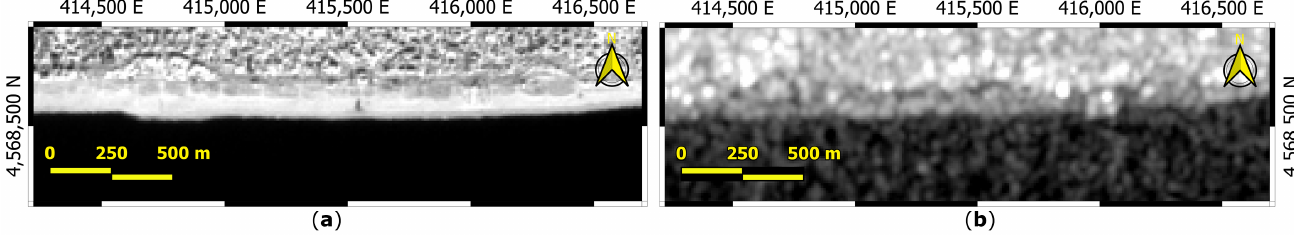
Figure 2. Crops of ( a ) the original S2 NIR (Near InfraRed) band and ( b ) S1 VH polarization